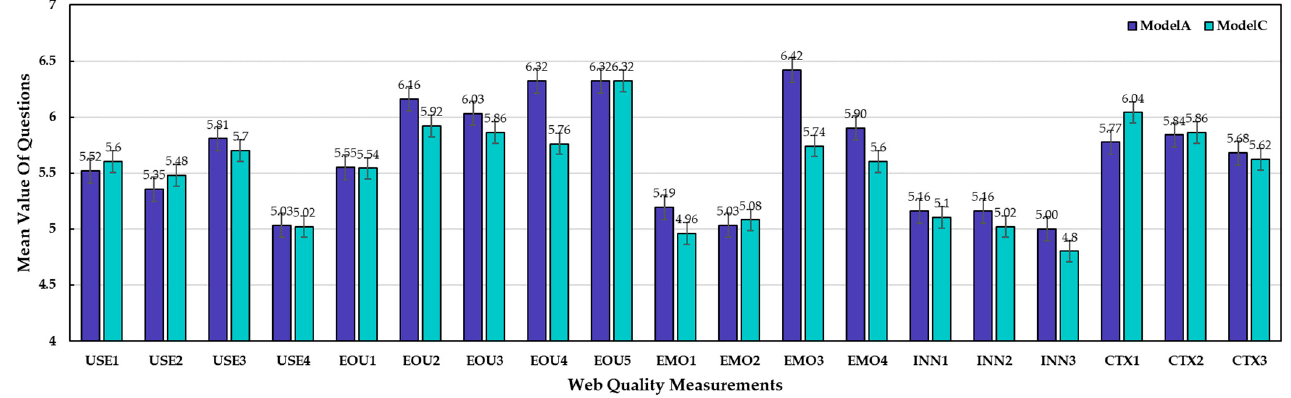
Figure 5. Website quality comparison between Model A and Model C.